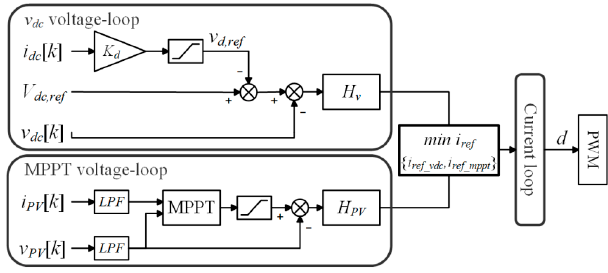
Figure 9. Control diagram of RC local controller.